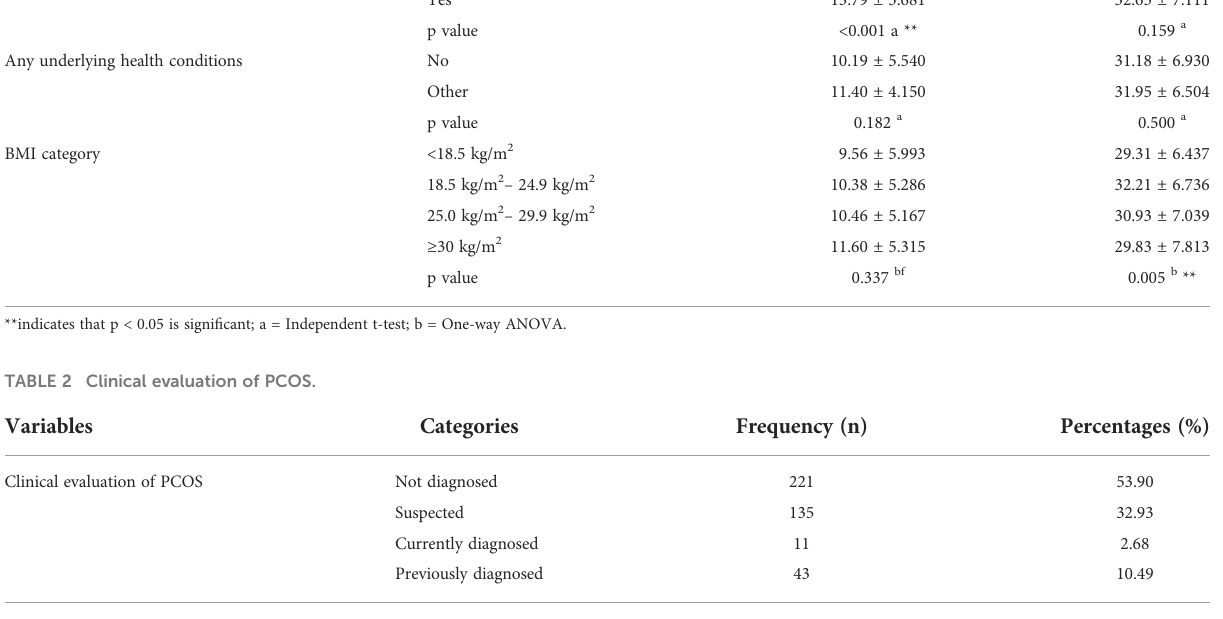
TABLE 3 Responses of respondents to knowledge